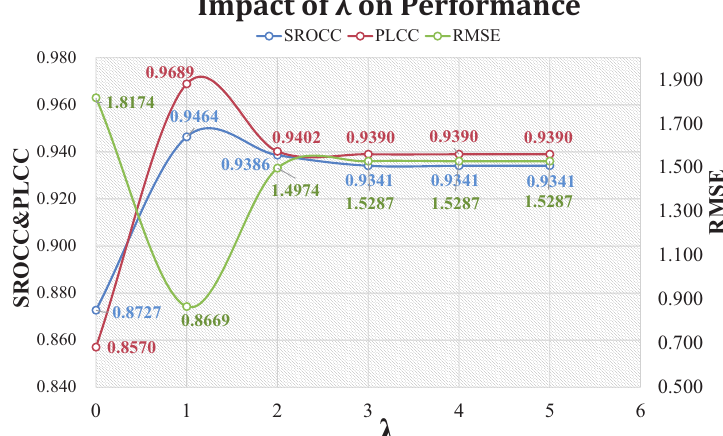
Figure 7. Analysis of performance of SROCC, PLCC and RMSE with λ varying from 0 to 5 on LIVE II dataset (145 Gaussian blur images), where λ represents the exponent coefficient of blurriness comparison function in Equation (10).